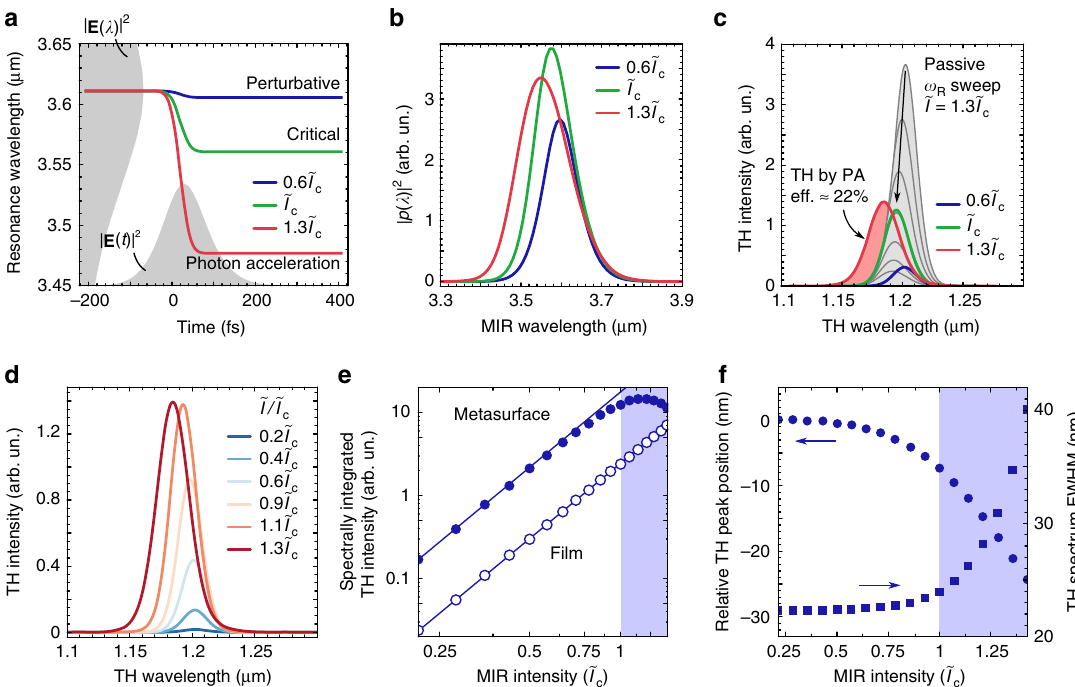
Fig. 3 Theoretical model of the photon-acceleration-induced blue-shifted harmonics generation. a Time-dependent resonant frequency of the metasurface due to four-photon absorption free carrier generation plotted for three normalized peak intensities of the mid-infrared (MIR) pulse: ~ I ¼ 0 : 6 ~ I (perturbative c regime, blue curve), ~ I ¼ ~ I (critical regime, green curve), and ~ I ¼ 1 : 3 ~ I (nonperturbative photon acceleration regime, red curve). Shaded areas: the c c frequency-domain (on the left) and time-domain (on the bottom) pro fi les of the incident pulse. b Spectra of the MIR electric fi eld inside the metasurface. c , d Predicted third harmonic generation (THG) spectra for different input MIR intensities. In ( c ), a comparison between the predictions of the models of time-dependent metasurface model (thick lines; coloring as in ( a )) and of the time-independent (thin lines) metasurfaces. The family of time-independent ~ I ¼ 1 : 3 ~ I = ω 0 metasurfaces satis fi es 0 < Δ ω . Filled red area: the portion of the spectrum inaccessible within the time-independent framework. < 4 % and R c R e Spectrum-integrated THG intensity versus input intensity for the unpatterned fi lm (open circles) and resonant metasurface (closed circles). THG from the fi lm is simulated as from a signi fi cantly nonresonant structure with γ R = 10 15 s − 1 with an intensity calibration coef fi cient that is adjusted for good agreement with the experiment at low intensities. Lines: guide-for-the-eye cubic dependences. f Intensity-dependent THG peak position (circles) and THG bandwidth (squares) generated by the metasurface. Shaded areas in ( e ) and ( f ): the nonperturbative photon acceleration